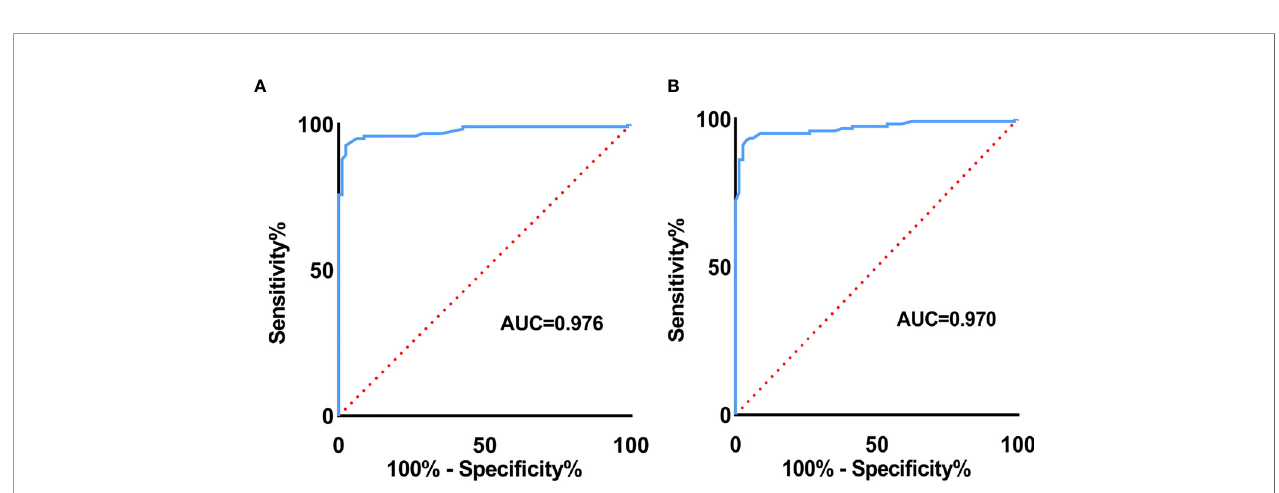
FIGURE 5 | ROC curve of E Median value (A) and Vs Median value (B) for malignant LN prediction.